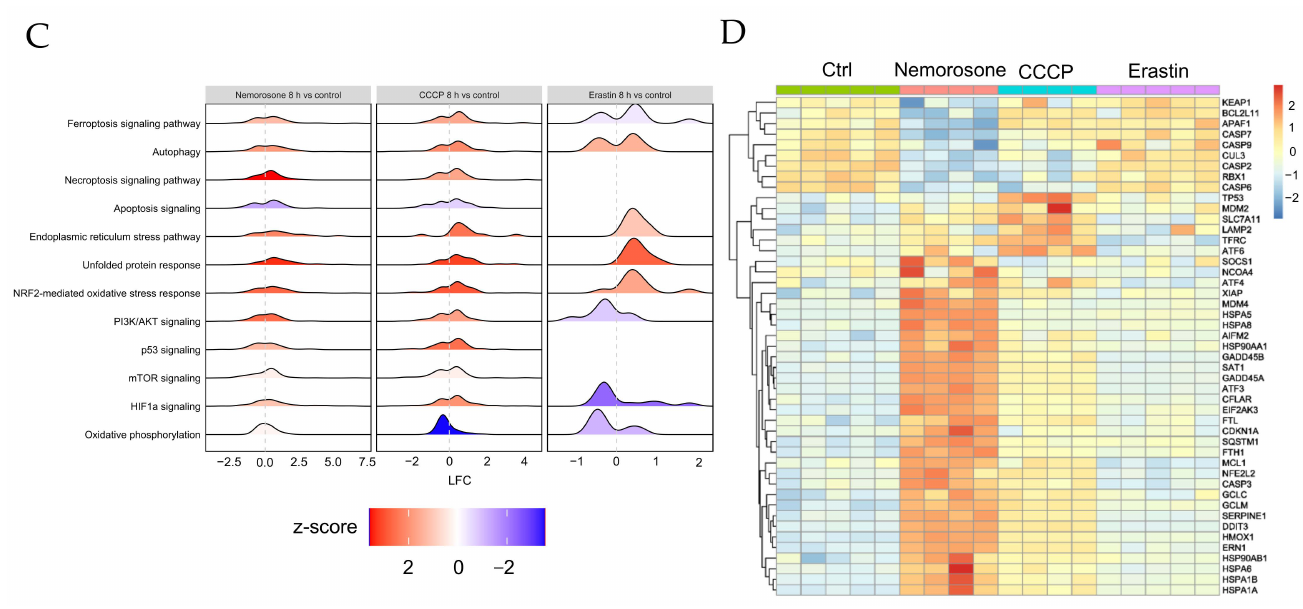
Figure 4. Genes and signaling pathways differentially expressed after treatment with nemorosone, CCCP, and erastin in HT1080 cells. ( A ) Heatmap of the expression of genes that are differentially expressed after both nemorosone (100 µ M) 2 h and nemorosone (100 µ M) 8 h treatments, compared to the control. Each column represents a sample; each row represents a gene. The genes have been clustered, and their expression has been centered and scaled. ( B ) Venn diagram showing differentially expressed (DE) genes, compared to the control, regulated by one, two, or all three treatments at the same time point (nemorosone 100 µ M, CCCP 50 µ M, erastin 20 µ M; 8 h). The direction of the arrows indicates upregulation or downregulation in the case of individual treatments. Each intersection shows the set of genes modulated by two or three treatments. The scatterplot below was made by plotting the LFC values (log 2 fold change), metric indicating how much the expression of a gene changes compared to the control condition of the corresponding genes indicated by the green intersection: positive values indicate higher expression than the control, and negative values indicate lower expression than the control. DE genes by erastin are colored according to their LFC value. Known ferroptosis-related genes are labeled. ( C ) Ridge plots showing the IPA (Ingenuity Pathway Analysis) pathways that were found to be significantly enriched in DE gene sets. Each density plot shows the distribution of the LFC values of the DE genes involved in the enriched pathway. Density plots are scaled per panel. The color indicates the z-score, which is an IPA metric that predicts activation (positive values) or inhibition (negative values) of the pathway. ( D ) Heatmap of the expression of selected ferroptosis-related genes. Each column represents a sample; each row represents a gene. The genes have been clustered, and their expression has been centered and